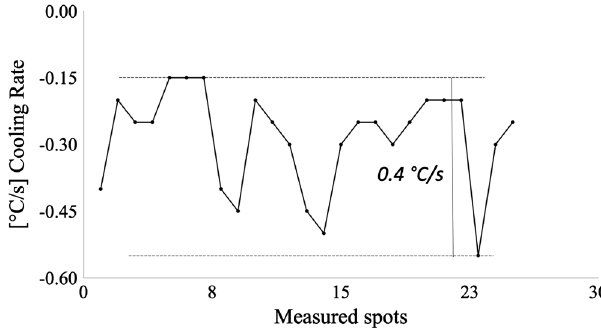
FIG. 21. Maximum cooling rates measured in some points of the prototypes